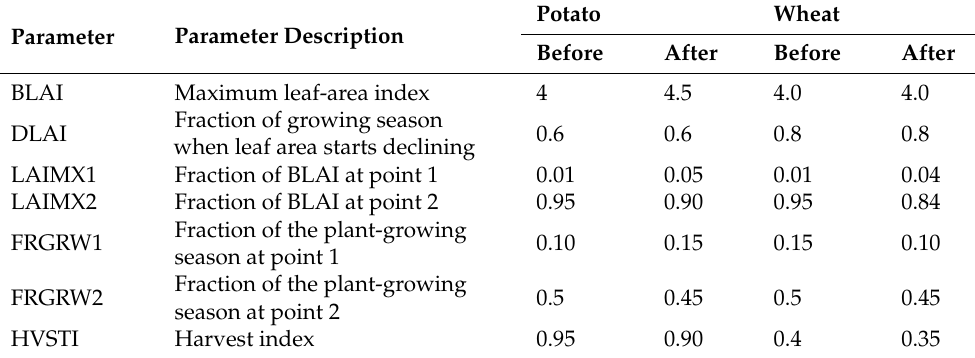
Table 3. Adjusted crop-parameters.